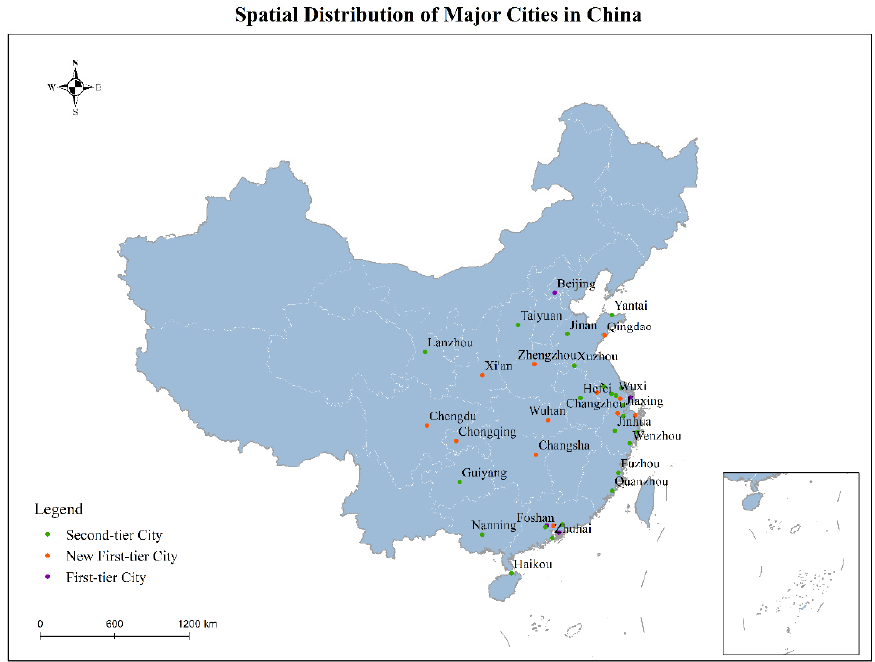
Figure 1. Special distribution of major cities in china.